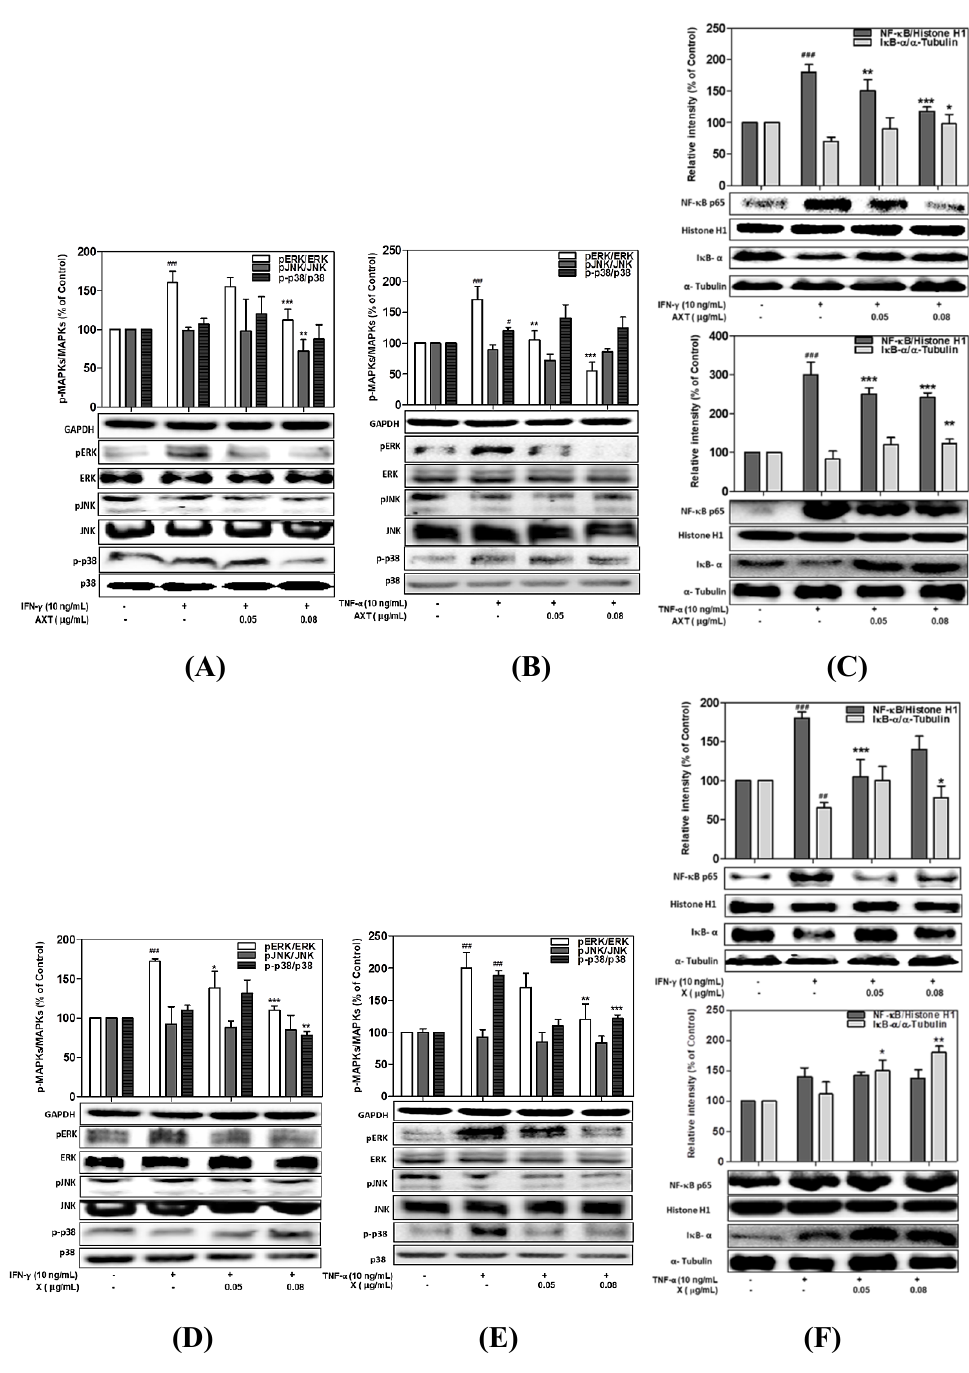
Figure 7. Effects of astaxanthin (AXT) and xanthophyll (X) on the MAPKs and NF-κB/IκB-α signaling pathway in IFN-γ or TNF-α-treated HaCaT cells. HaCaT cells were incubated with two concentrations of AXT and X (0.05-0.08 μg/mL) and stimulated with IFN-γ or TNF-α (10 ng/mL). Quantitative band-intensity for p-MAPKs ( A, B, D, E ) and p- NF-κB/IκB-α ( C, F ) were analyzed by densitometry, normalized to the level of GAPDH, histone H1, or α-tubulin, and calculated as a percentage of the basal response. Data are means ± standard deviation (SD) of independent experiments. Note: Significant differences # p < 0.05, ## p < 0.01, and ### p < 0.001 from control vs. the TNF-α/IFN-γ-(10 ng/mL)-induced group, and * p < 0.05, ** p < 0.01, and *** p < 0.001 IFN-γ or TNF-α (10 ng/mL)-induced group vs. astaxanthin and xanthophyll treated group.